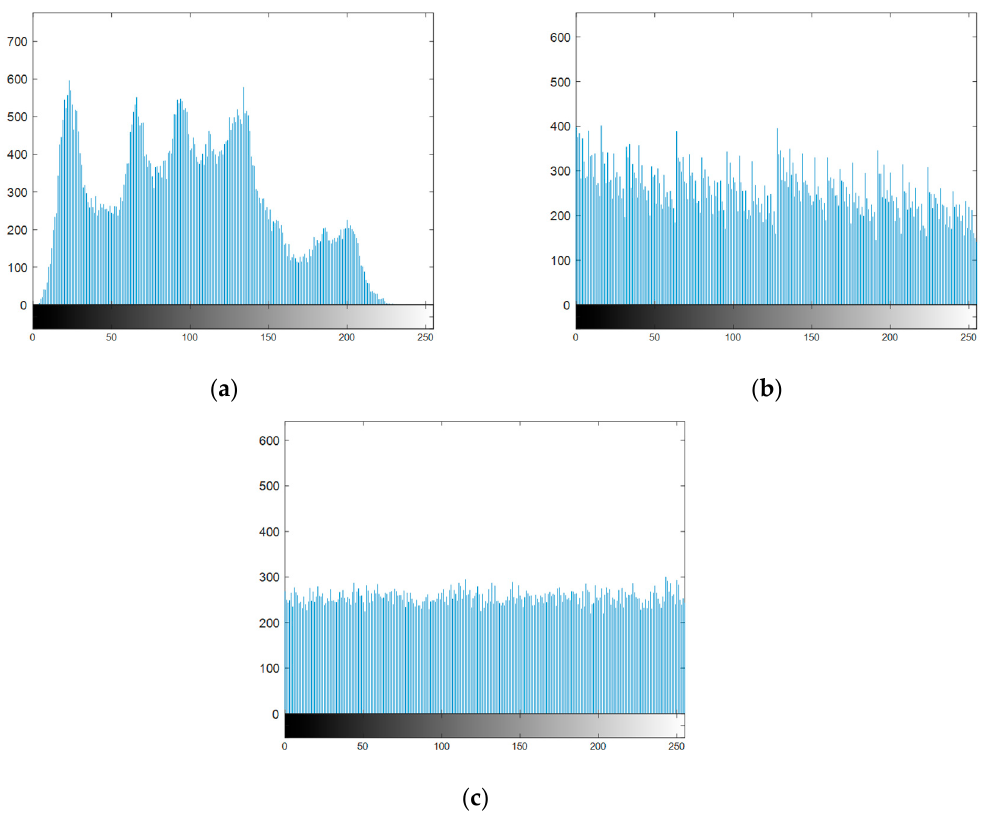
Figure 9. Histogram comparison of Lena: ( a ) plain image; ( b ) scrambled intermediate cipher image; ( c ) cipher image.